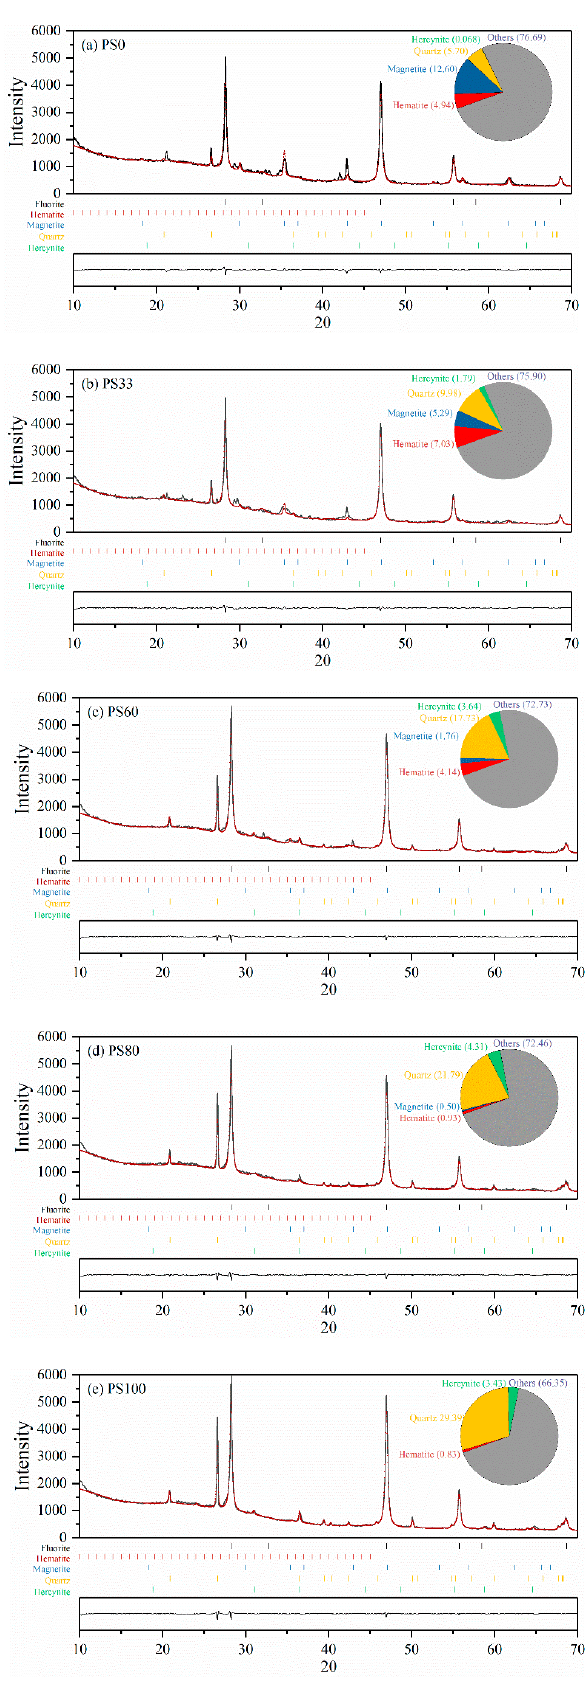
Figure 2. Rietveld refinement of ( a ) PS0, ( b ) PS33, ( c ) PS60, ( d ) PS80, and ( e ) PS100.